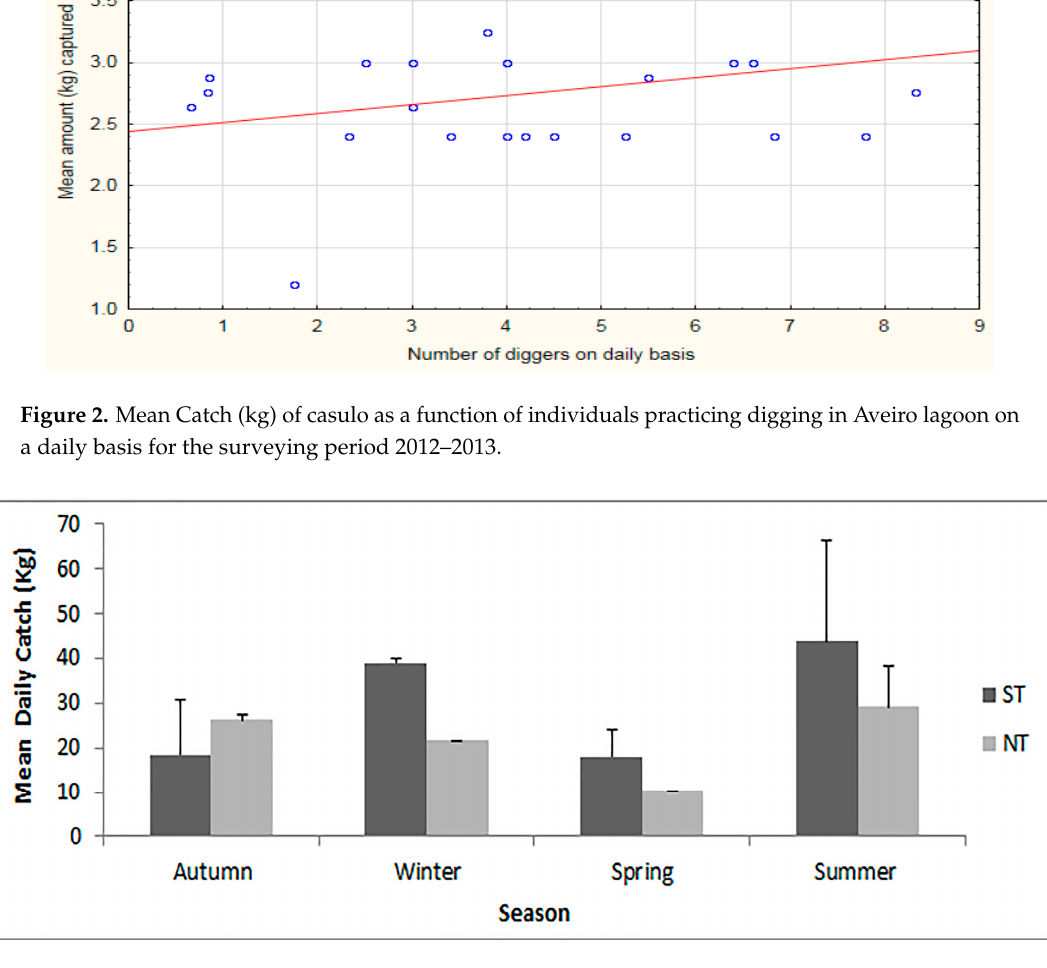
Figure 3. Mean daily catch for seasonal and tidal ranges. ST = spring tide; NT = neap tide. Whiskers show +1 standard error.